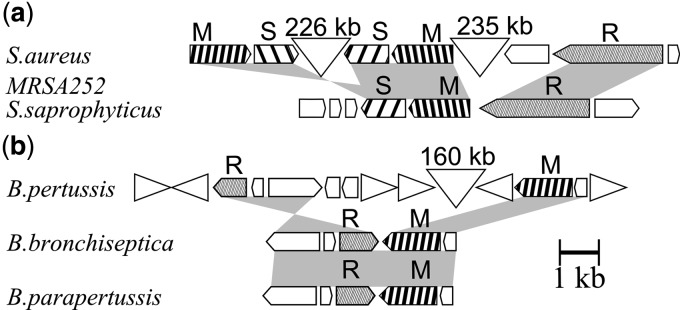
Examples of gene organization of separated R-M systems. (a) Gene organization of orthologous type I R-M systems (group 8 in Tables 2, S5) from S. aureus and Staphylococcus saprophyticus. In the figure are presented separated R-M systems from S. aureus MRSA252 genome; the genomic context of orthologous R-M systems is similar and not shown here. (b) Gene organization of orthologous Type II R-M systems (group 1 in Tables 2, S5) in the genomes of B. pertussis, B. bronchiseptica and B. parapertussis. Orthologous genes are connected by gray areas, the genes coding for MTases are shown by arrows with black-and-white strips, the genes coding for REs are shown by light gray arrows, other ORFs are shown by empty arrows, extended inserts between genes are marked by triangles with specified length in kb, and IS-481 elements are shown as triangles with one vertical edge.